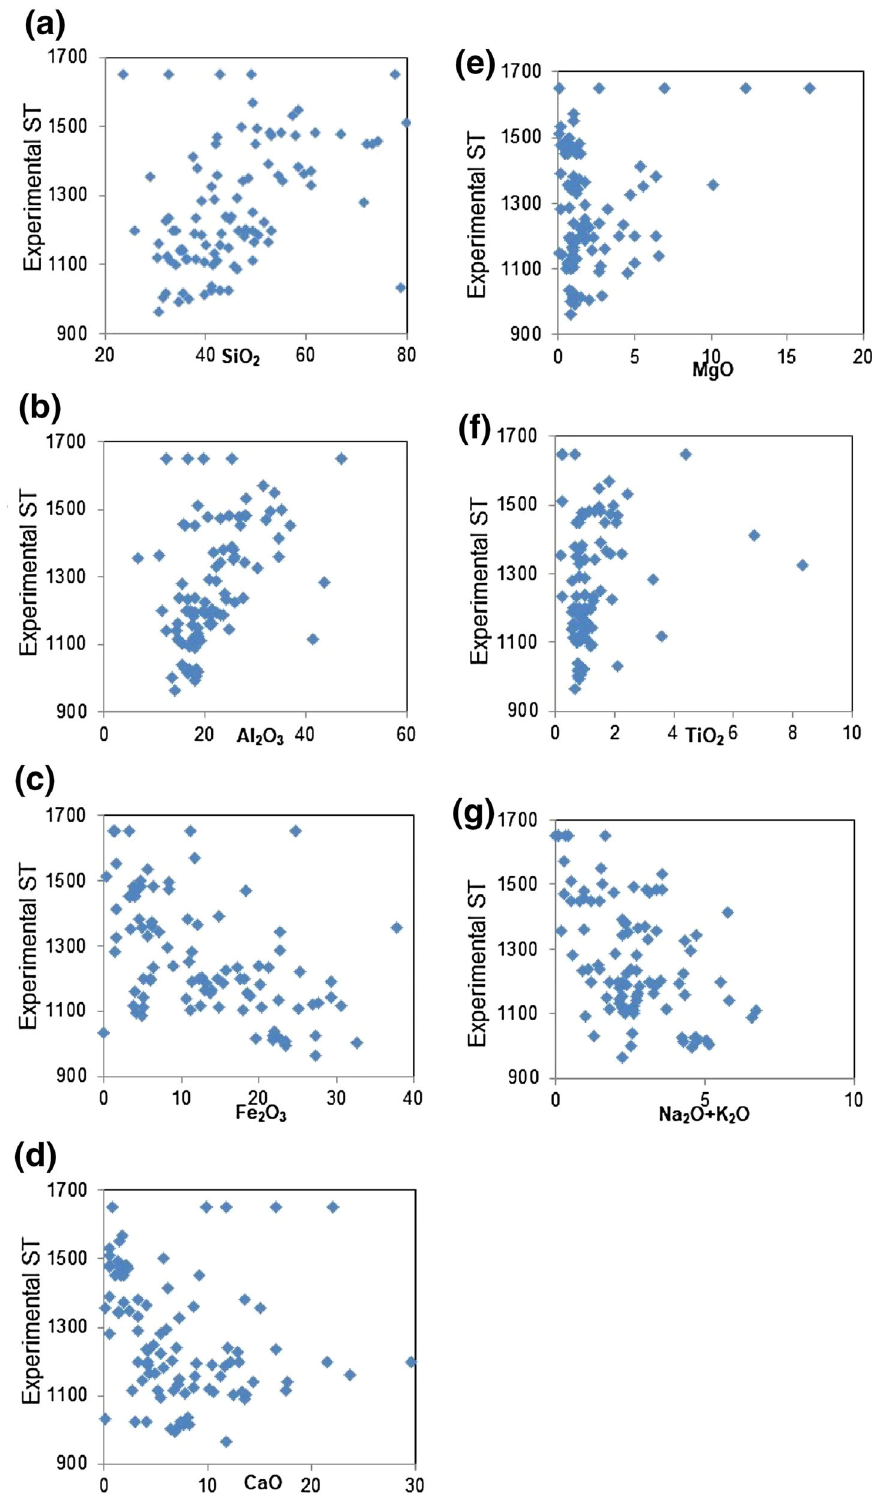
Fig. 3 Cross-plots of weight percentages (wt%) of individual metal oxides versus HT